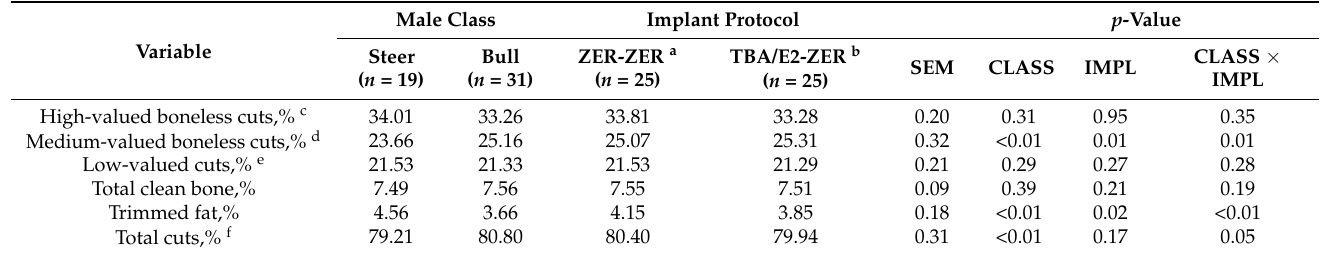
Table 9. Carcass fabrication yield traits according to male class and implant protocol (Experiment